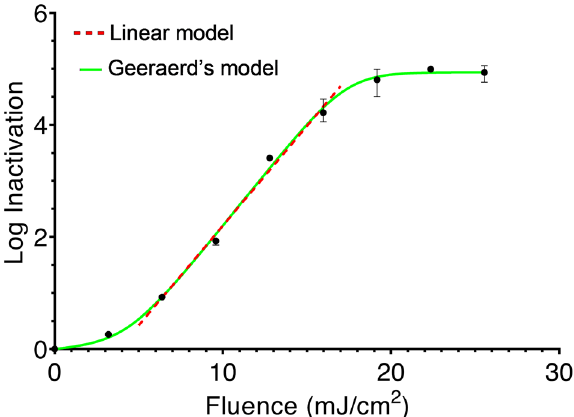
Figure 2. Fluence-response profile for M. abscessus in PBS solution exposed to 280 nm UV-LED radiation. Regression curves based on a log-linear model (Red dotted line) and Geeraerd’s model (Green line) are shown. Each data point is the mean (n = 3), and error bars represent the range of